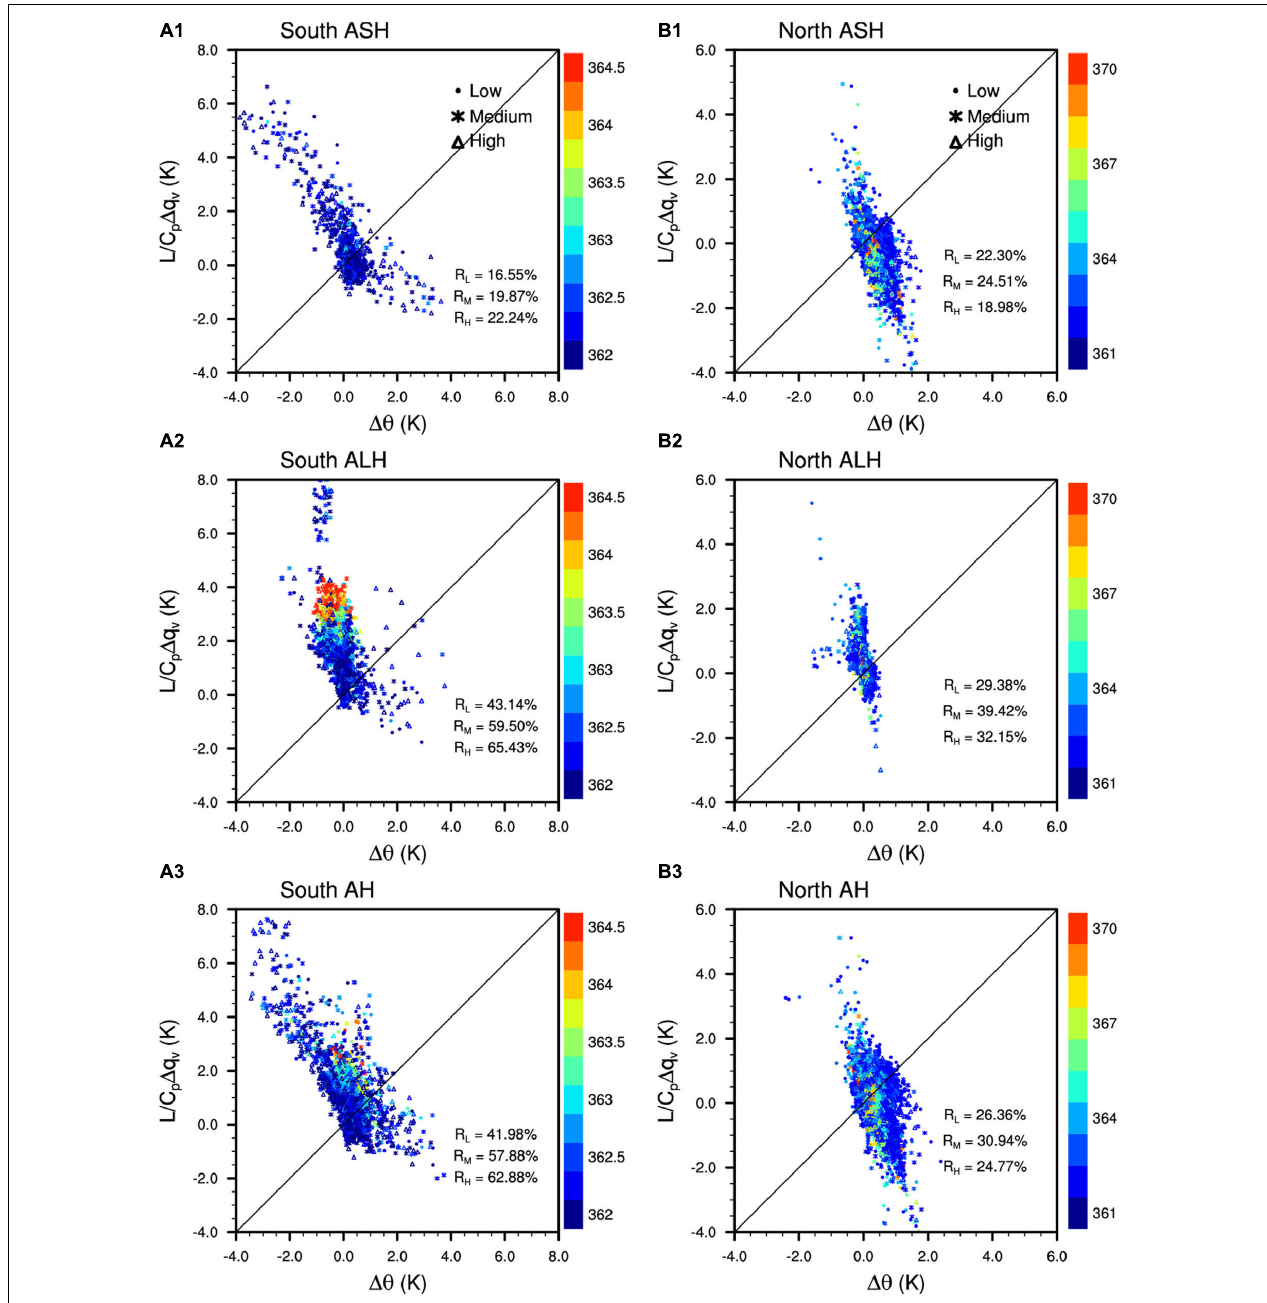
FIGURE 10 | (A,B) Scatter plots of changes in humidity ( L / C p (cid:49) q v , K) versus changes in temperature ( (cid:49) θ , K) associated with extreme heat stress (98th percentile θ e ) events for the ASH, ALH, and AH runs. The triangle, star, and dot represent high-/medium-/low- density urban areas, colored by their associated θ e value. Left and right panels denote south and north urban regions,